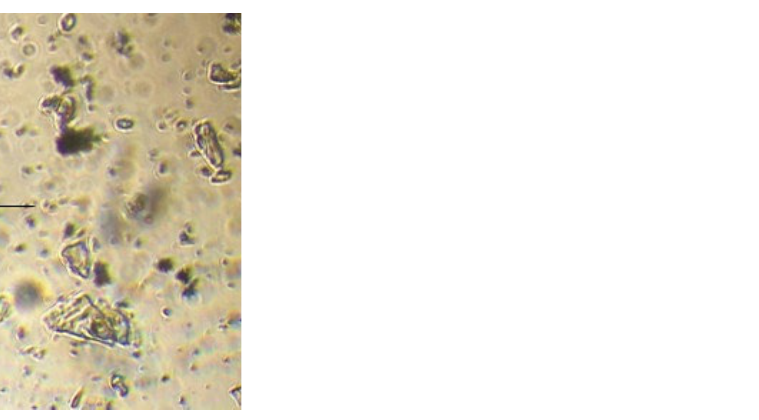
Figure 4. Micrographs of the mechanical mixture of H 2 SO 4 -doped PANi (20 wt.%) and talc (80 wt.%). The pictures obtained using scanning electron microscopy, also, confirm the formation of core/shell pigments (Figure 5).